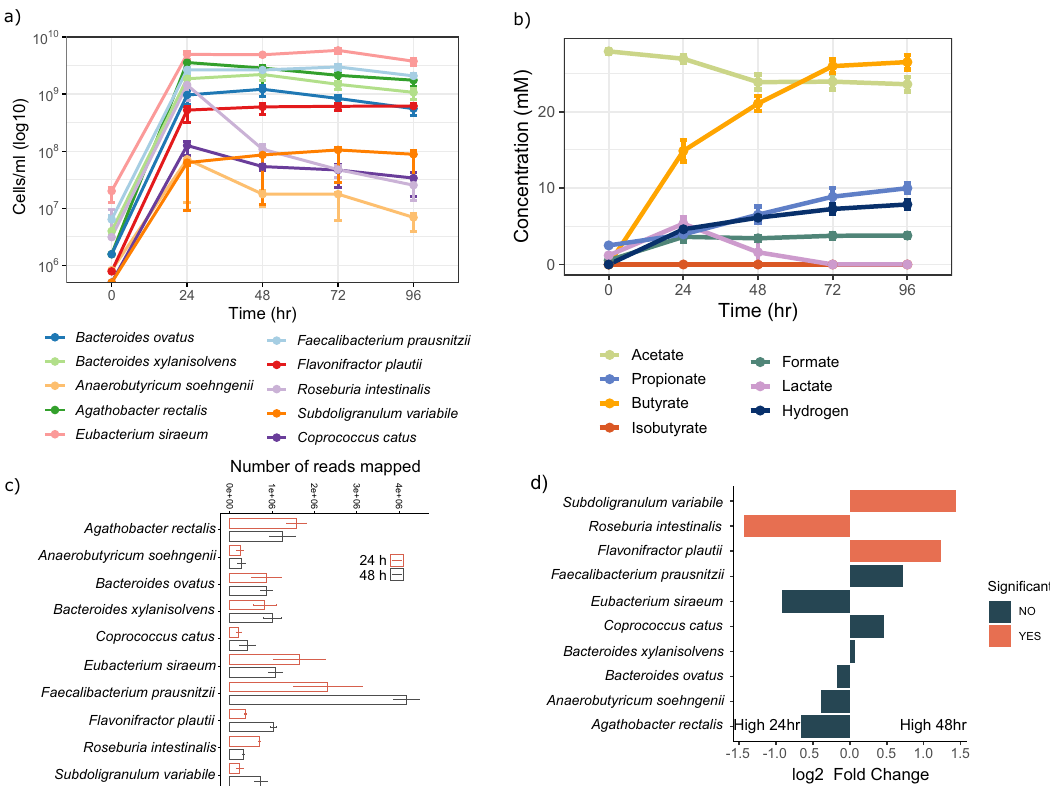
Fig. 4 Metabolite and compositional dynamics of Db-MM. a Abundance of strains at different timepoints in Db-MM ( n = 4). b Fermentation products observed in Db-MM ( n = 4). c Number of metatranscriptome reads mapped to each of the ten Db-MM strains at 24 h and 48 h ( n = 3). d Comparison of log2-fold change in number of metatranscriptome reads mapped to each of the ten Db-MM strains at 24 h and 48 h ( n = 3). The error bars in panel a, b and c represent standard deviation values for